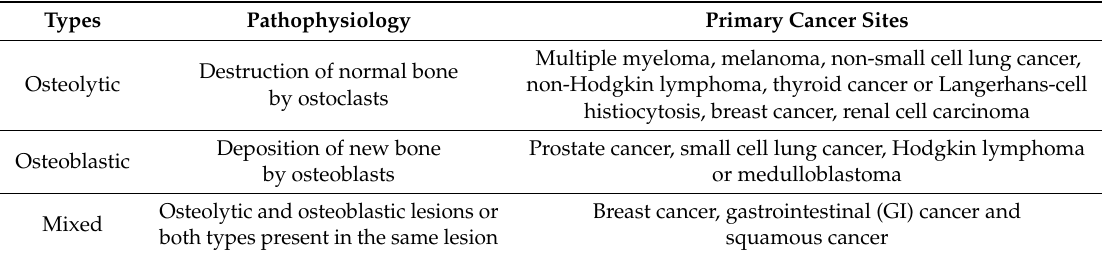
Table 1. Bone metastases characteristics [15].